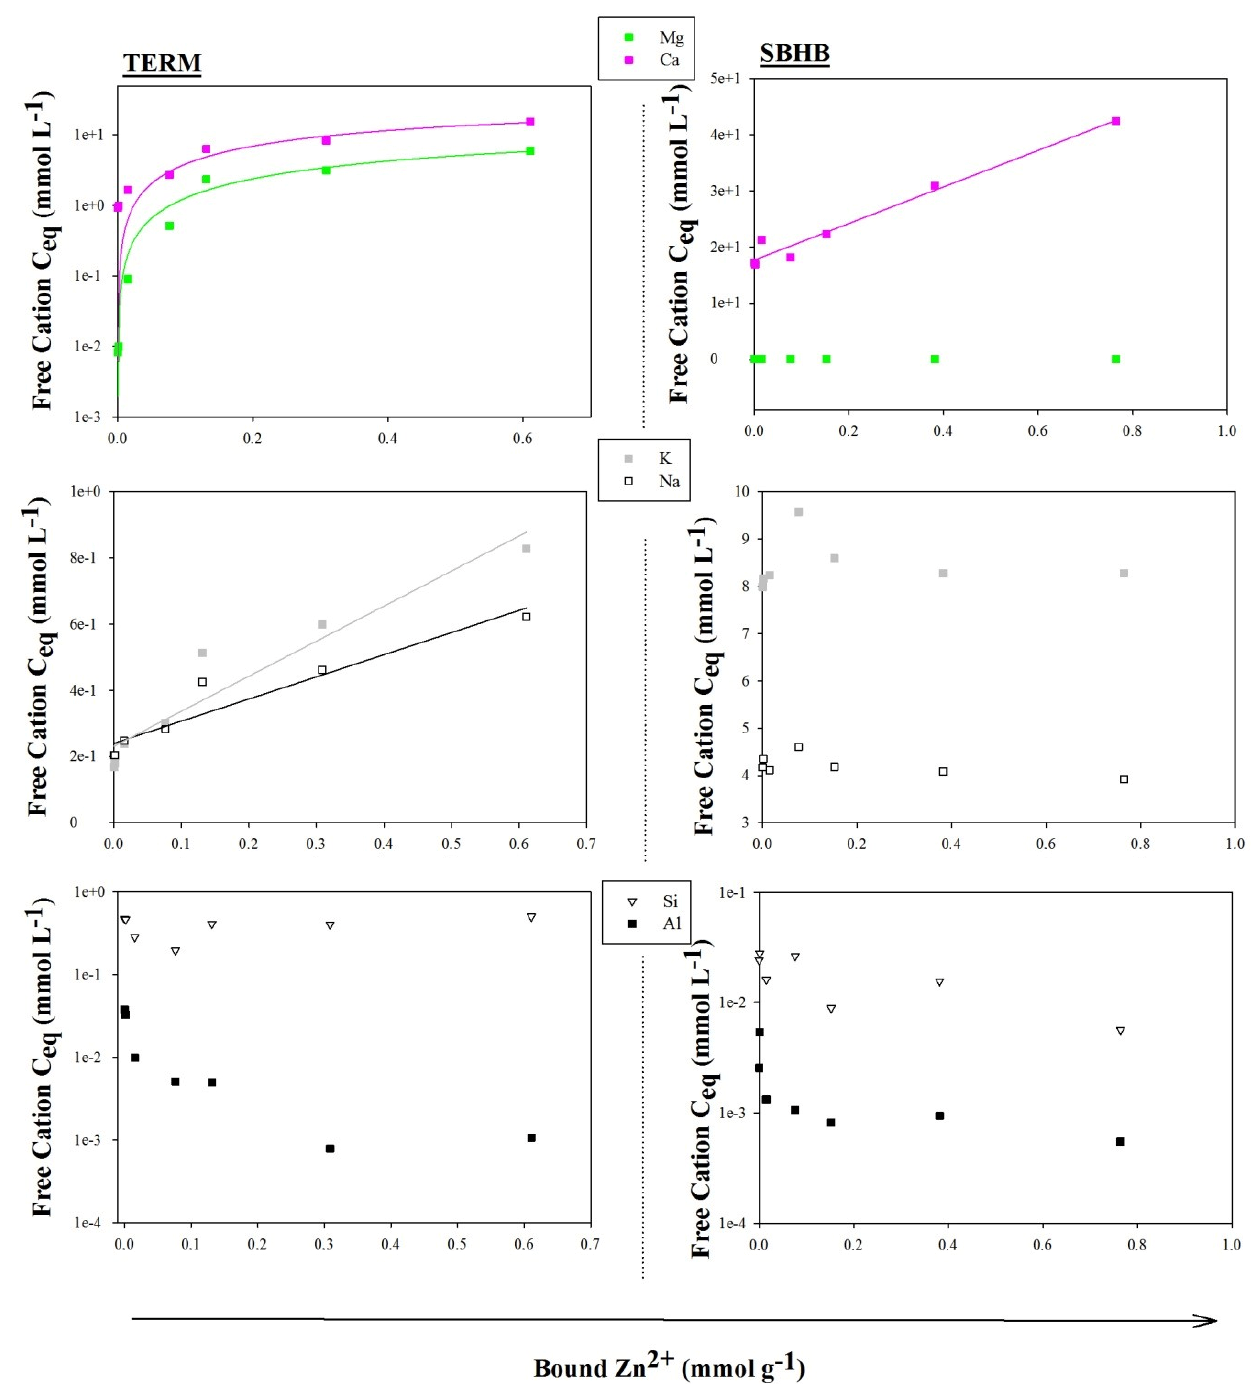
Figure 7. Major elements (Mg, Ca, K, Na, Si, Al) concentrations at equilibrium as a function of bound Zn for the Thermo- Evolved Red Mud (TERM) and the Slag Base Hydraulic Binder (SBHB).